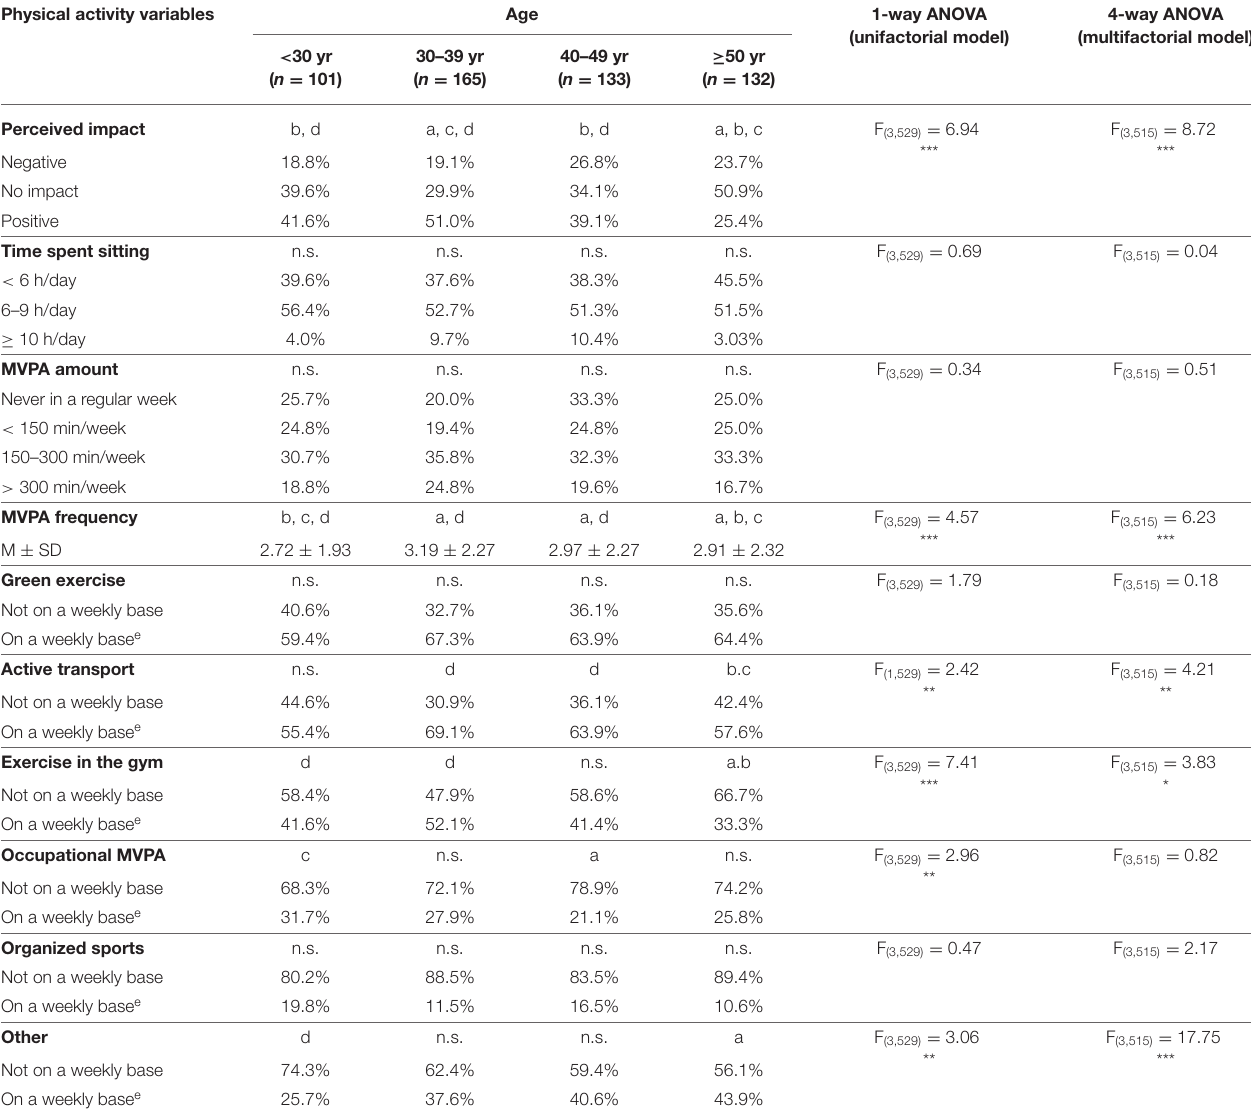
TABLE 4 | Physical activity profile of Italian immigrants in Norway, by age ( n = 531). Physical activity